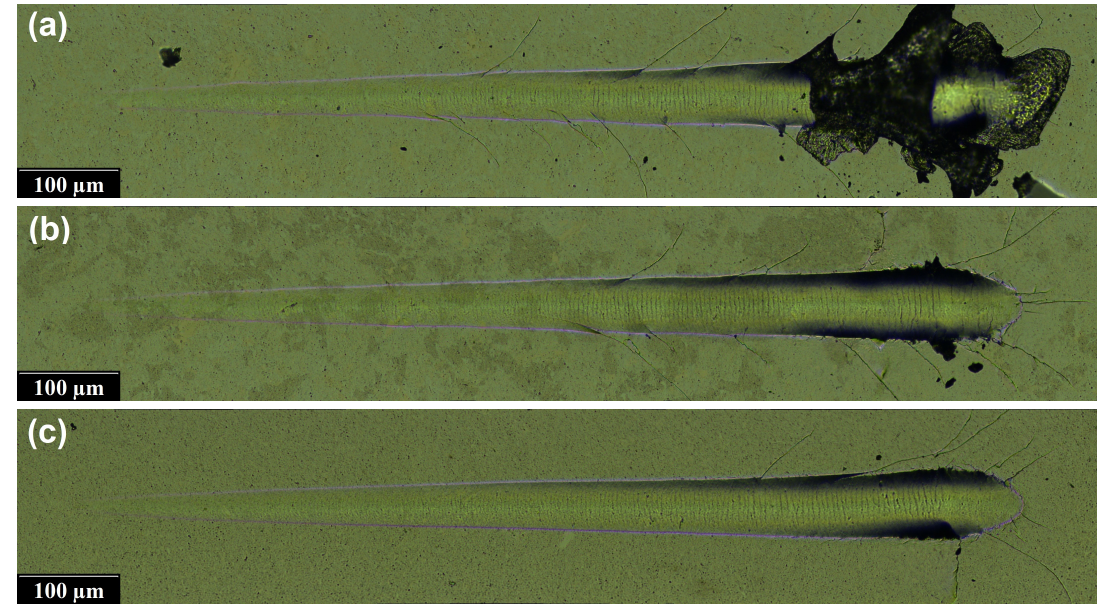
Figure 7. Scratches on (a) Fe_Al_Si, (b) FeAl_Si and (c) FeSi_Al